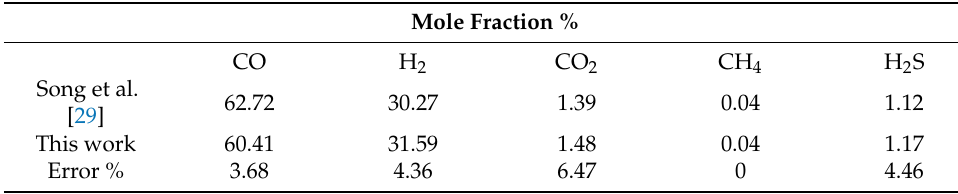
Table A3. Validation of simulation results of gasification.